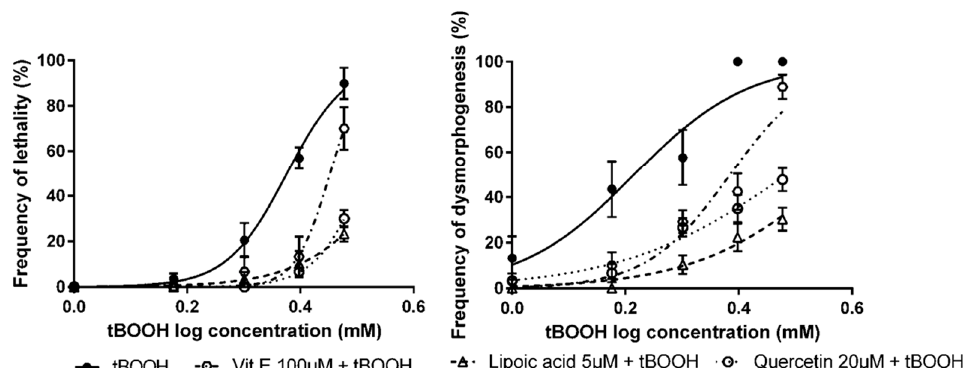
Figure 4. Concentration–response curves for lethality and dysmorphogenesis of tBOOH alone or in combination with different antioxidant compounds.